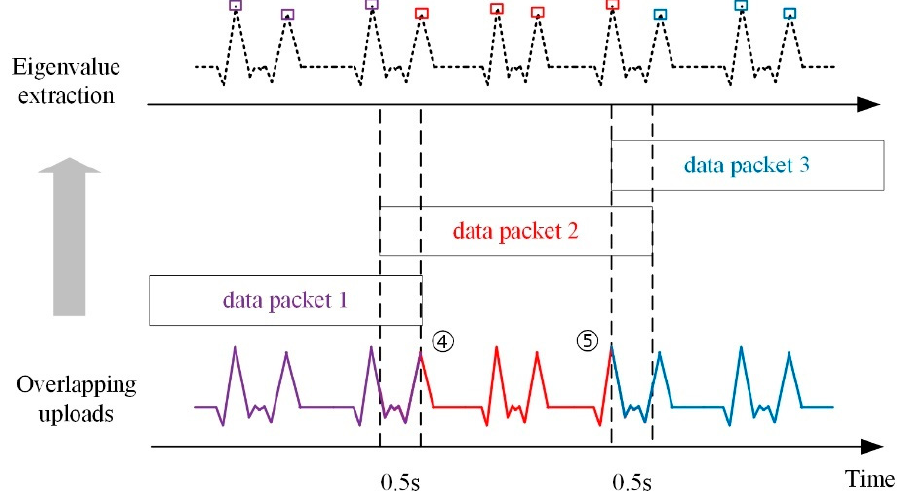
Figure 9. The overlapping upload mechanism.